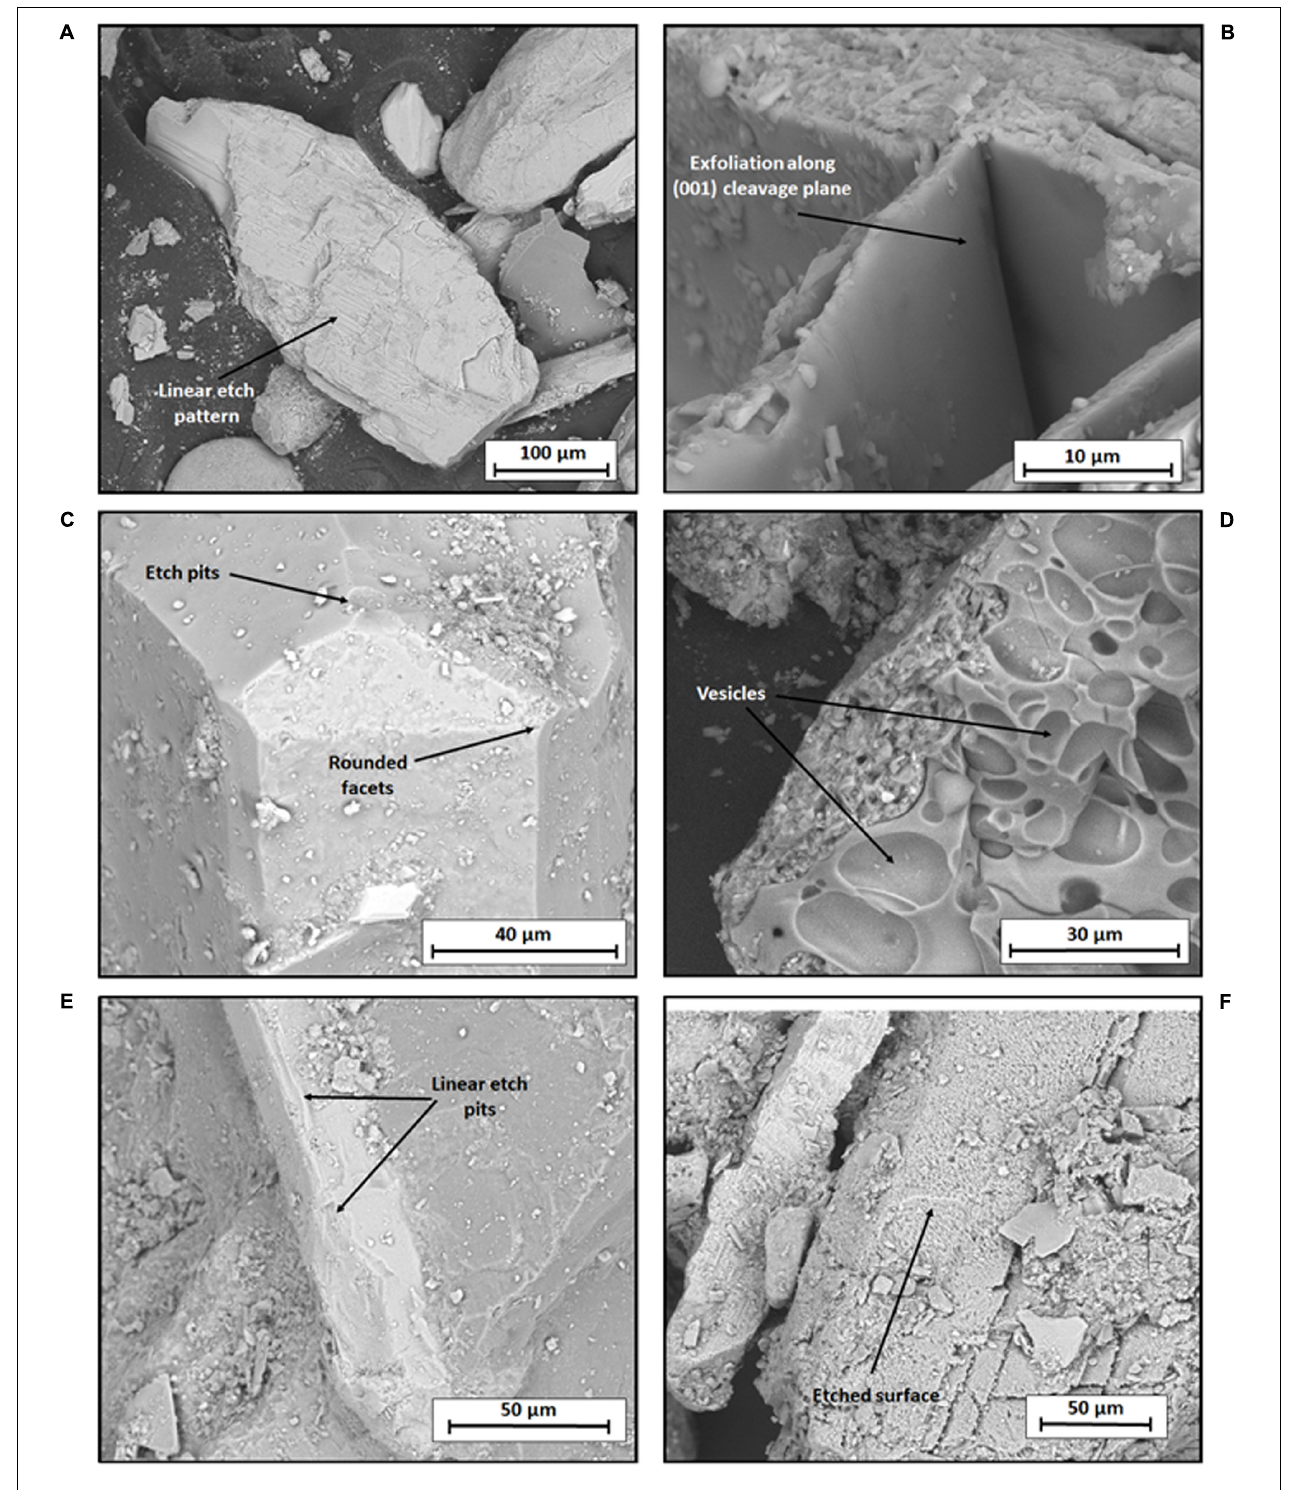
FIGURE 6 | SEM images of minerals in the hyporheic zone sediments of Crescent Stream, including silicate-bearing minerals (A–D) and calcium and phosphate bearing minerals (E,F) . (A) shows a large (300 µ m long) euhedral pyroxene grain with physical abrasions and linear etched pattern on the surface; (B) shows a biotite grain with physical alteration and exfoliation along the (001) cleavage plane; (C) shows an olivine grain with a euhedral surface, slightly rounded facets and few small etch pits on the surfaces; (D) shows volcanic glass and ash with a vesicular surface and coating of fine grained amorphous-nanocrystalline on the left side of the glassy particle surface; (E) shows an elongate apatite grain with crystallographically controlled etch pits; (F) shows calcite minerals with extensively etched surfaces.